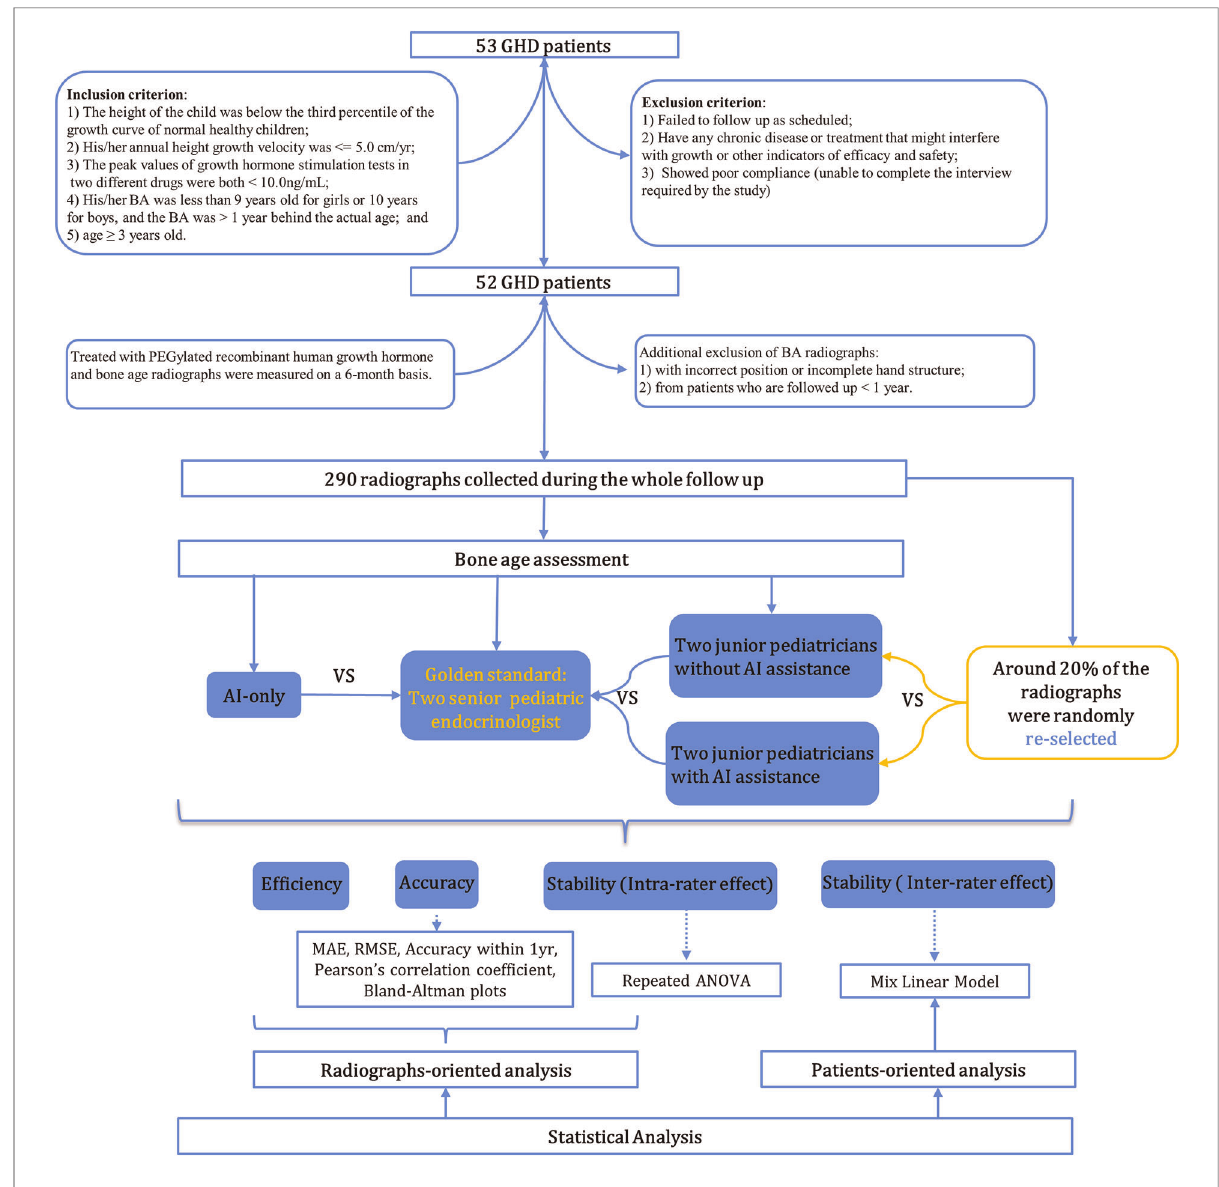
FIGURE 1 Flowchart of case selection and study